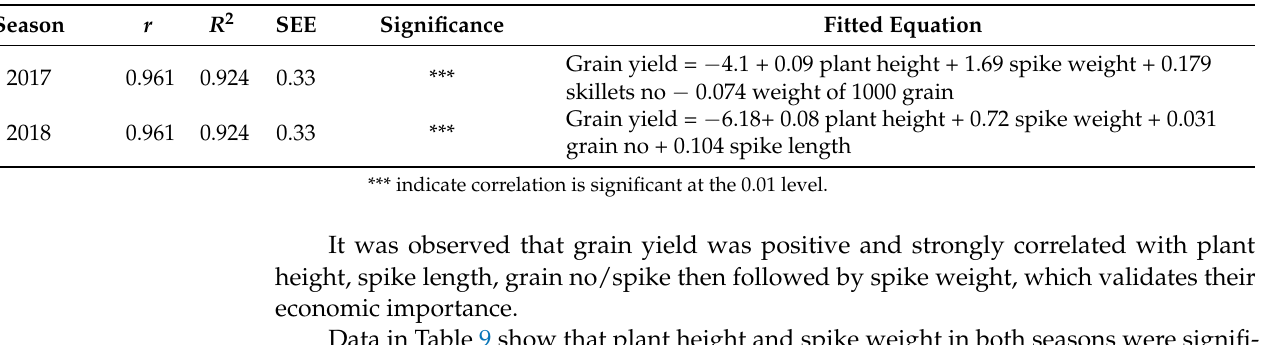
Table 9. Correlation coefficient ( r ), coefficient of determination ( R 2 ) and standard error of the estimates (SEE) for predicting grain yield for S I (2017) and S II (2018)